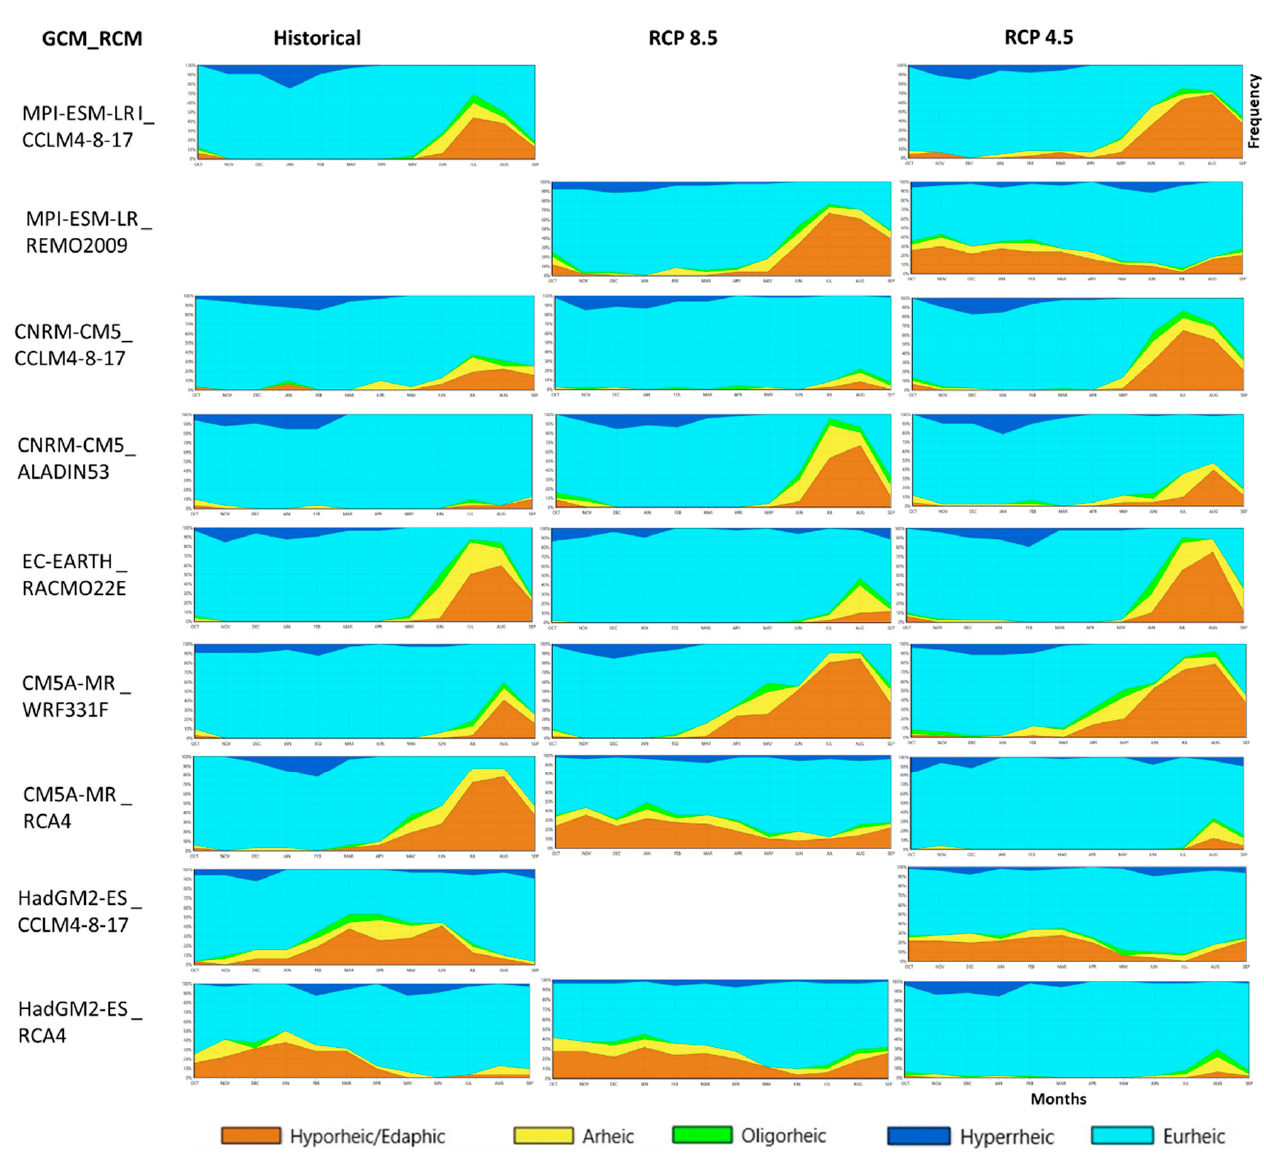
Figure 14. Aquatic states frequency graphs of historical scenarios: from 1955 to 2005 ( left ); and from 2021 to 2071 under RCP 8.5 scenario (in the middle ) and RCP 4.5 ( right ).